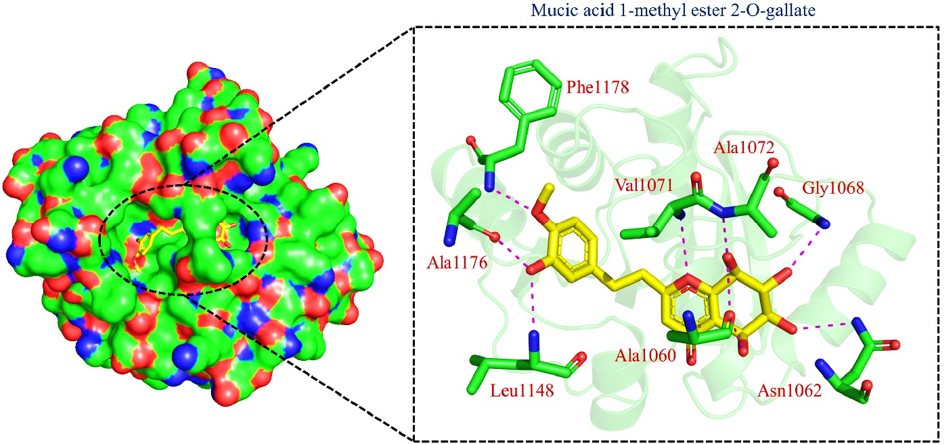
Figure 2. Binding of TCM42798 in the cavity of Mac-I. The right surface representation shows the binding mode of mucic acid 1-methyl ester 2-O-gallate (yellow sticks) inside the binding cavity. The right panel represent the 3D interaction pattern, where the TCM42798 is shown as yellow sticks, while the interacting residues are given in green sticks. The interactions (hydrogen bonds) are shown in pink